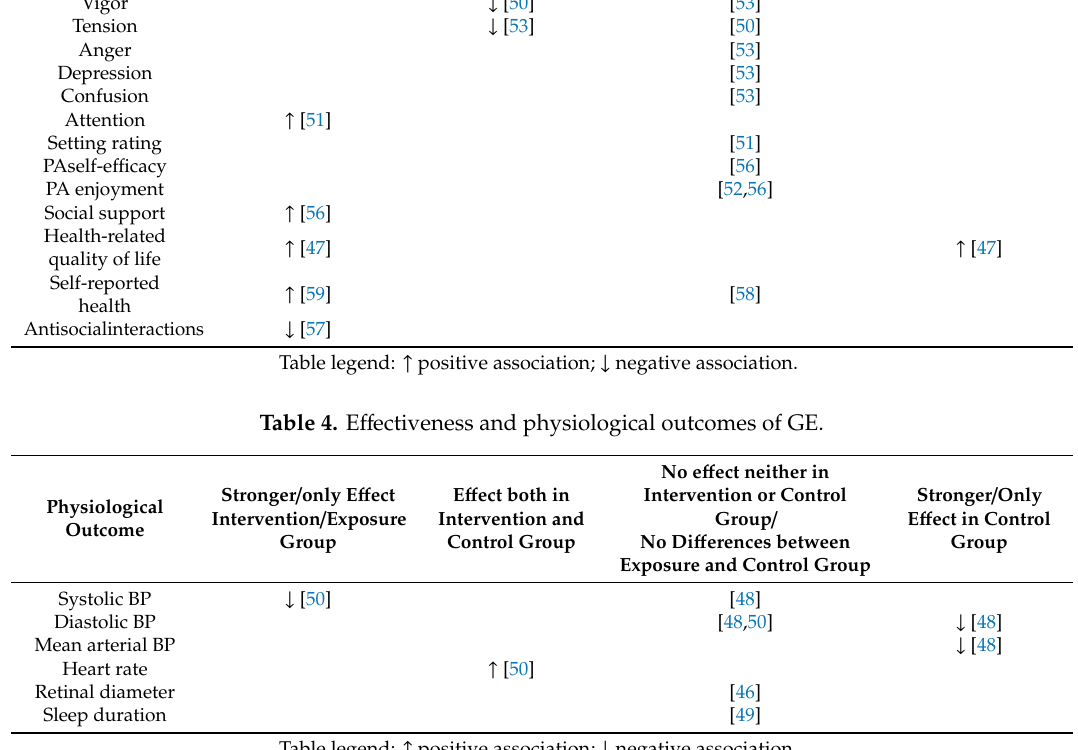
Table legend: ↑ positive association; ↓ negative